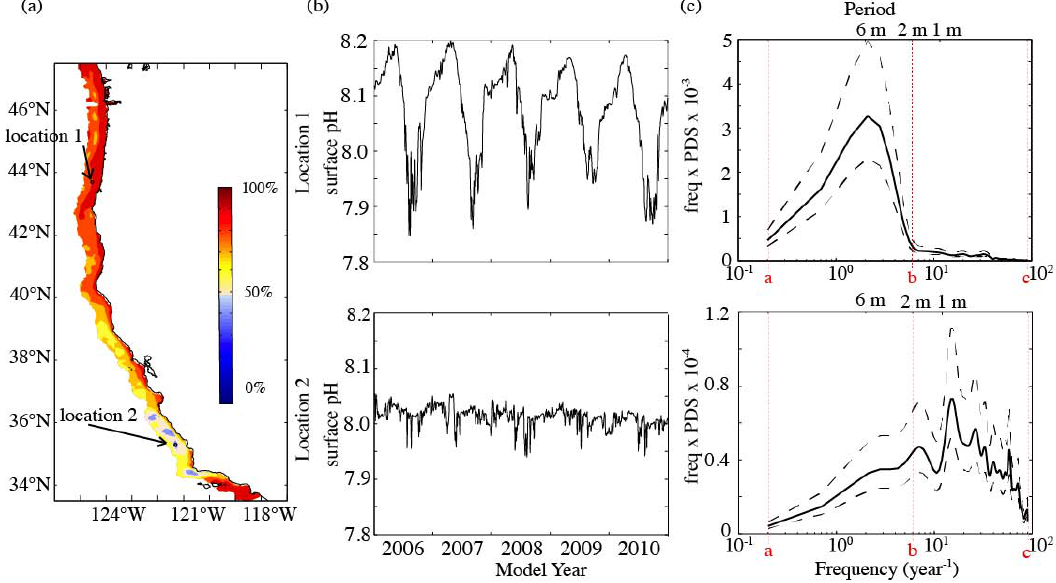
Fig. 2. Analysis of variability of surface pH. (a) indicates the percentage of the total variability of surface pH that occurs at frequencies less than b = 6yr − 1 . The arrows point out the locations of the two example sites described in panels (b) and (c) . (b) Time series of surface pH over 5yr for two distinct example locations and (c) a variance-conserving plot of the frequency × power density spectrum (PDS) vs. the frequency of the Fourier transformed time series. The black solid line represents the PDS and the black dashed lines envelope the ± 95% confidence interval. The red dashed lines show the boundaries a , b and c of the integrals applied in Eq. (1).